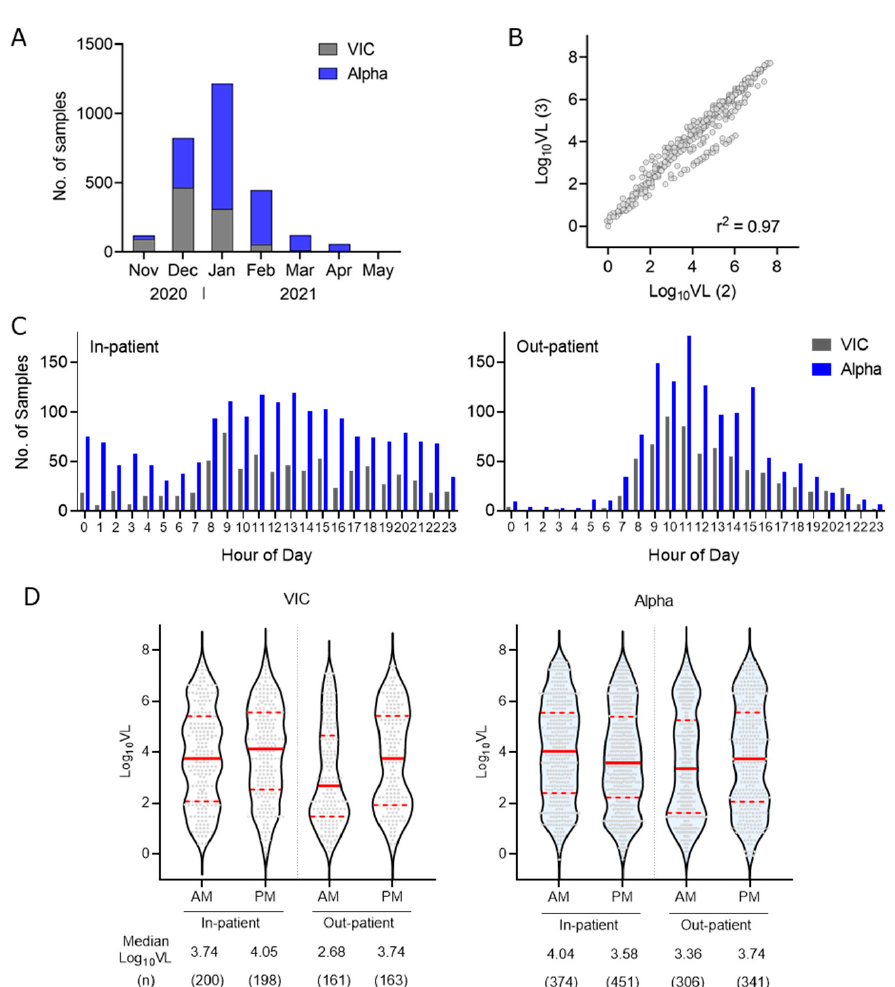
Figure 1. ( A ) Monthly COVID-19 PCR samples detected in Oxford UK as Victoria (VIC, grey) or Alpha (blue) strain between Nov 2020 and May 2021. ( B ) Viral Load (VL) estimates for the VIC samples derived from either 2 (ORF1, N; x -axis) or 3 (ORF1, N and S; y -axis). Ct values agreed closely (r 2 = 0.97). ( C ) Sample request times from in-patient and out-patient groups listed by hour of the day and by VIC or Alpha strain. ( D ) Violin plots of Log 10 VL of the infecting virus strain (VIC/Alpha), partitioned by in- and out-patient groups (location) and by sample time (a.m., 06:00–11:59; p.m., 12:00–17:59). Median Log 10 VL is depicted with a solid red bar and the interquartile range with hashed red